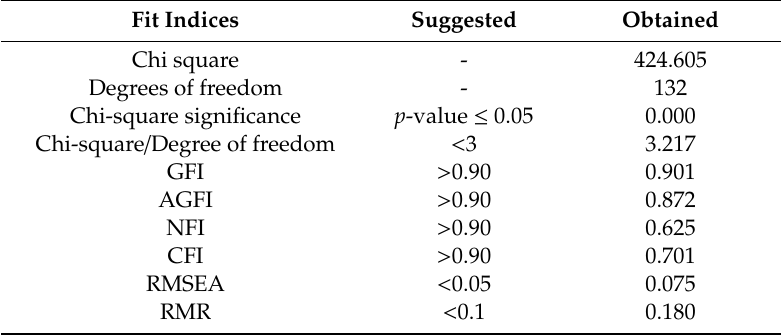
Table 12. Fit indices and their acceptable thresholds in causation